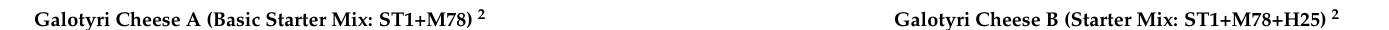
Table 1. Populations (log CFU/g) of the primary starter S. thermophilus ST1, the NisA+ co-starter Lc. lactis subsp. cremoris M78, and the adjunct L. plantarum H25 strains selectively enumerated infour sequential processing steps of three independent batches of pilot-scale-produced, traditional Galotyri PDO cheese 1 .